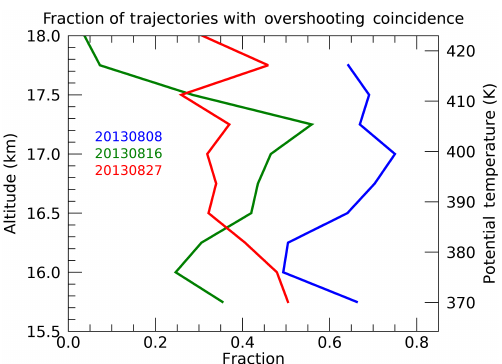
Figure 9. The fraction of back trajectories that intersected OTs dur- ing the 7 previous days for the three SEAC 4 RS flights on 8 Au- gust (blue), 16 August (green) and 27 August 2013 (red) shown in Figs. 6, 7 and 8,